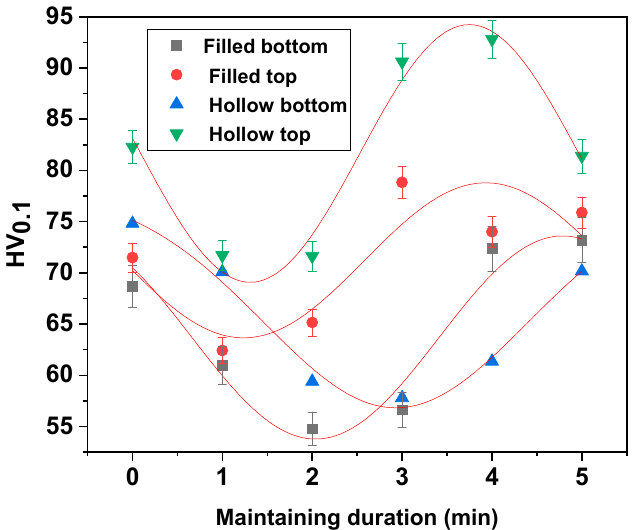
Figure 6. The microhardness obtained in the case of the sintering heat treatment at 930 °C.